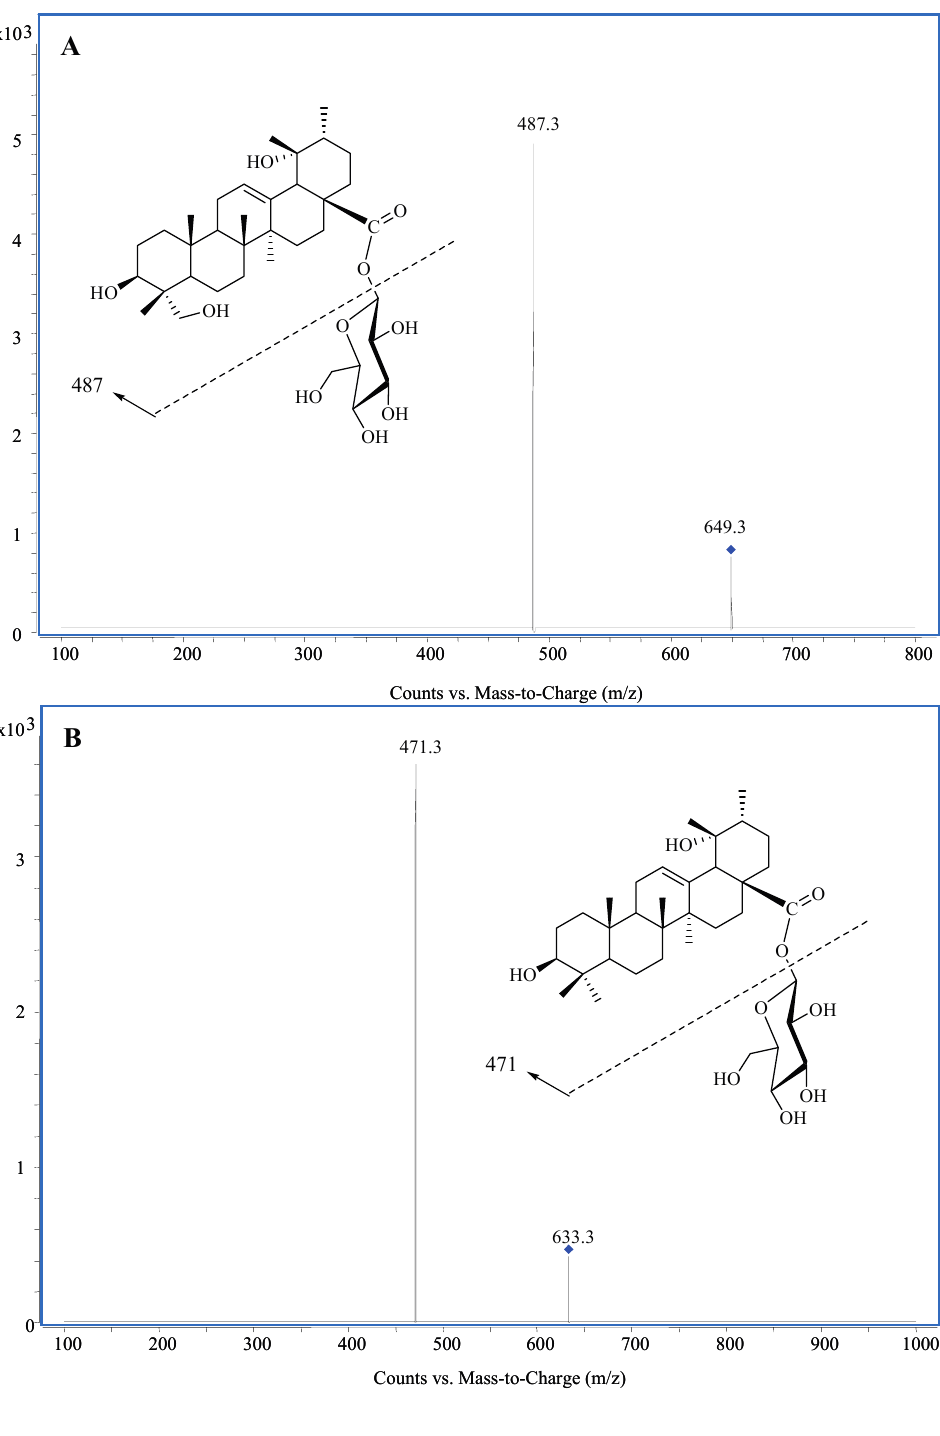
Figure 1. Representative MS/MS spectra and structures: ( A ) PDC; ( B )